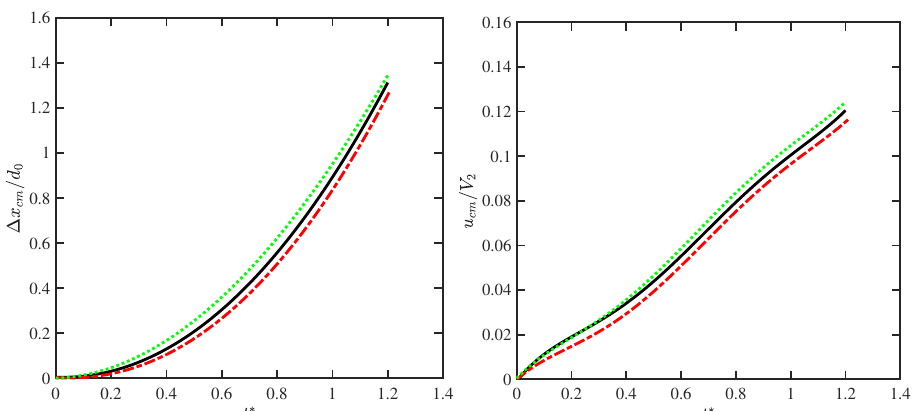
Figure 8. Time history of the normalized drift ( left ) and streamwise velocity ( right ) of the water column CM: CFD II (green dotted line), CFD III (black solid line), and reference numerical solution (red dashed-dotted line).